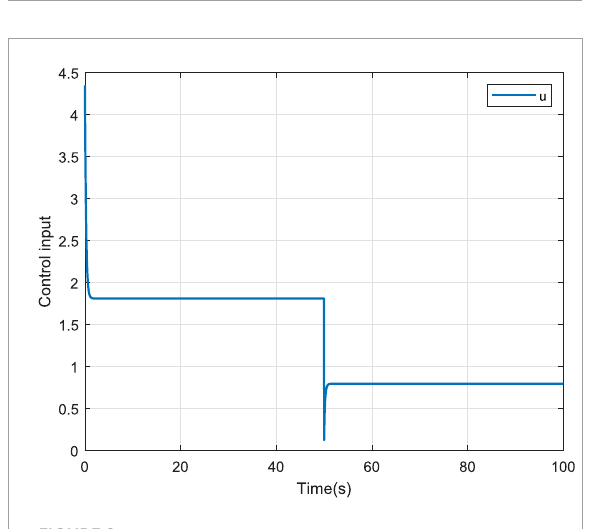
FIGURE 7 Tracking error with NN compensation.